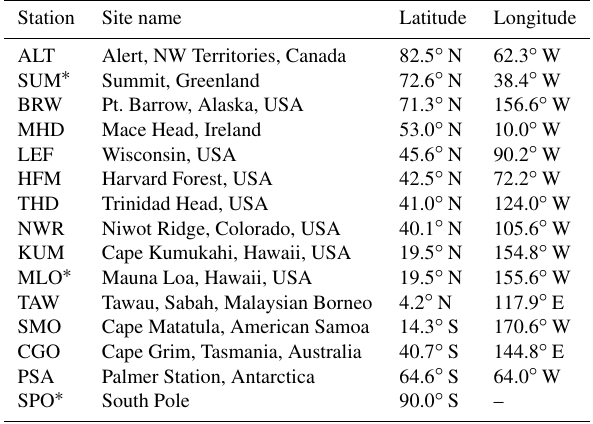
Table 3. Summary and location of ground-based surface VSLS measurements used in TransCom-VSLS, arranged from north to south. All sites are part of the NOAA/ESRL global monitoring net- work, with the exception of TAW, at which measurements were ob- tained by the University of Cambridge (see main text). ∗ Stations SUM, MLO and SPO are elevated at ∼ 3210, 3397 and 2810m, re- spectively.